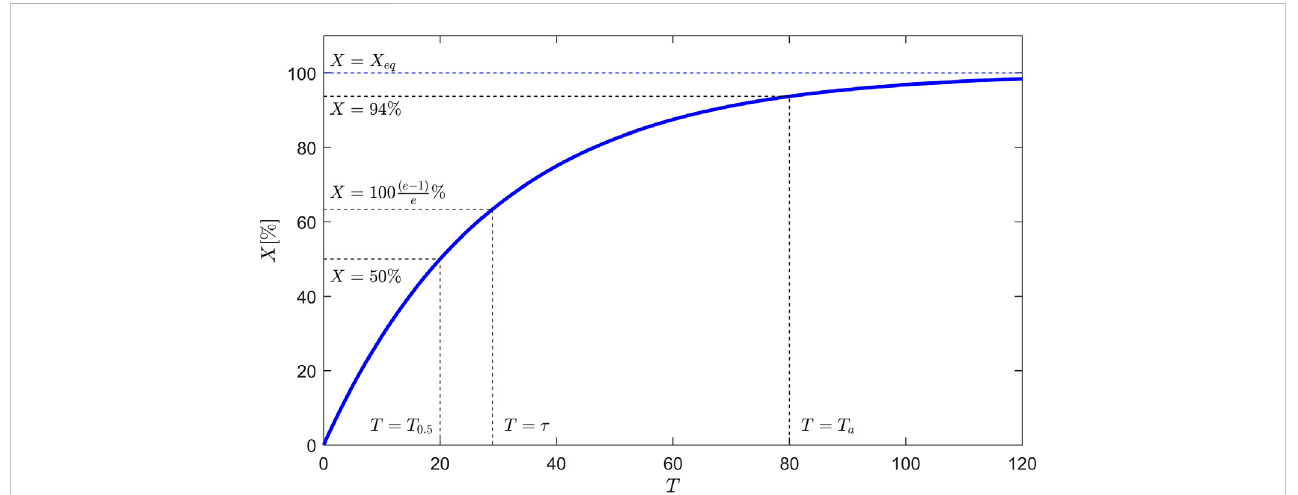
FIGURE 7 De fi nitionsketchoftimescales( T a ; τ ; T 0 . 5 )andadaptation X (in%,wheretheequilibriumisde fi nedas X eq =100%)foranexponentialdecayfunction. Half of the changes are achieved at T (cid:1) T 0 . 5 , for this particular exponential decay function equal to 20 years. The adaptation timescale T a is then 80